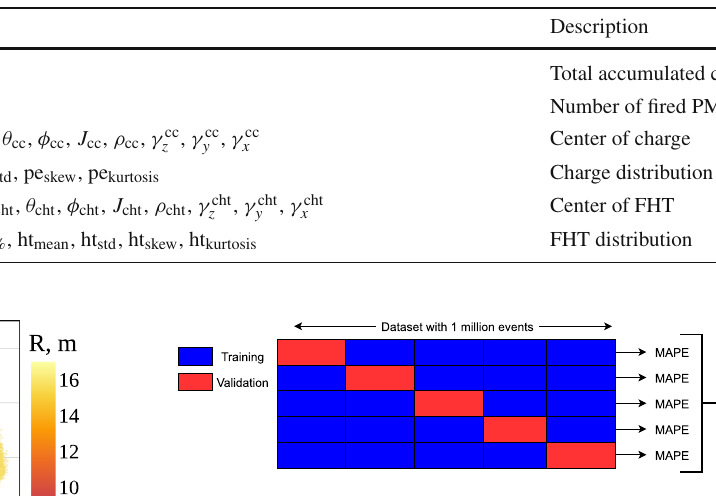
Fig. 8 5-fold cross-validation